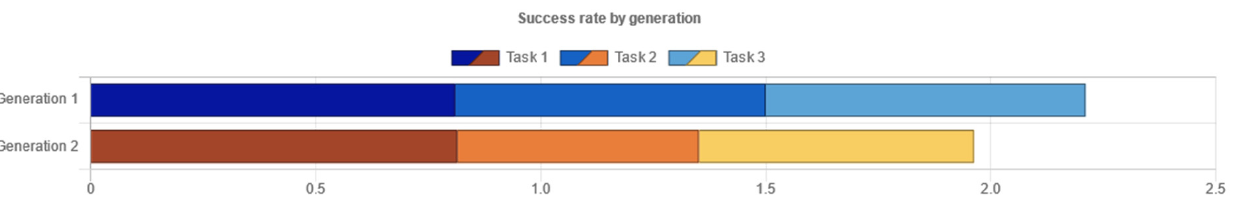
Figure 12. Success rate by generation.